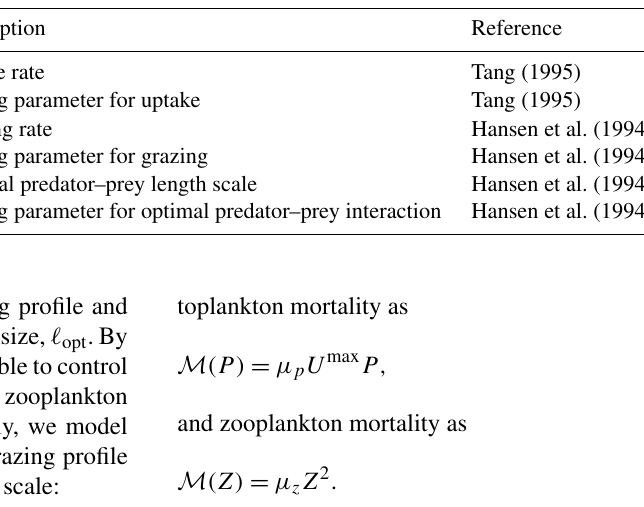
Table 2. Parameters and values used in the ecosystem model implemented in MAMEBUS. Coefficients without explicit references are chosen by the